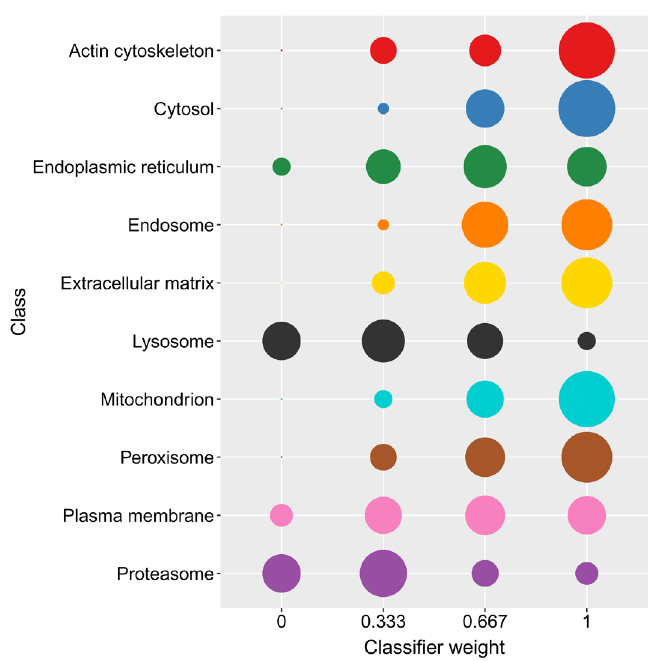
Figure 20. Visualisation of the transfer learning parameter optimisation procedure. Each row displays the frequency of observed weights (along the columns) for a specific sub-cellular class, with large dots representing higher observation